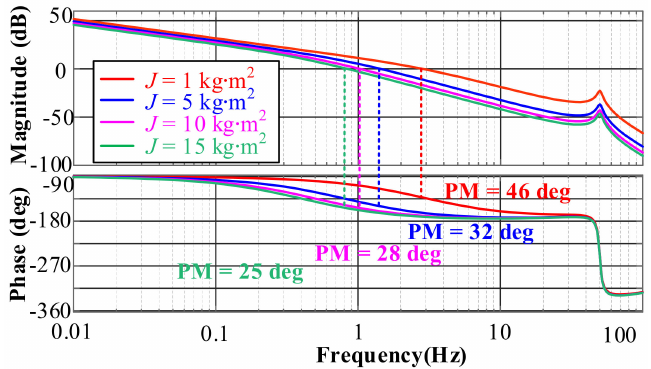
Figure 9. The Bode diagrams of the traditional VSG under different J .